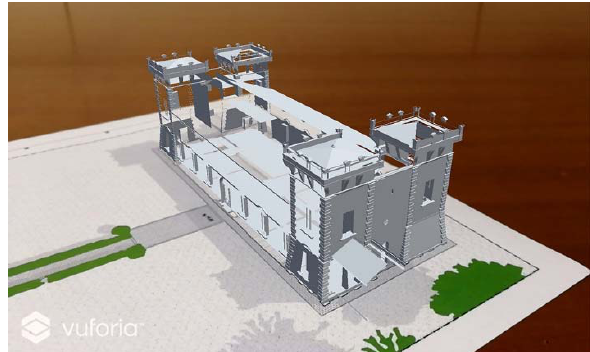
Figure 6: Relationships between geometric surface generation and normal directions.